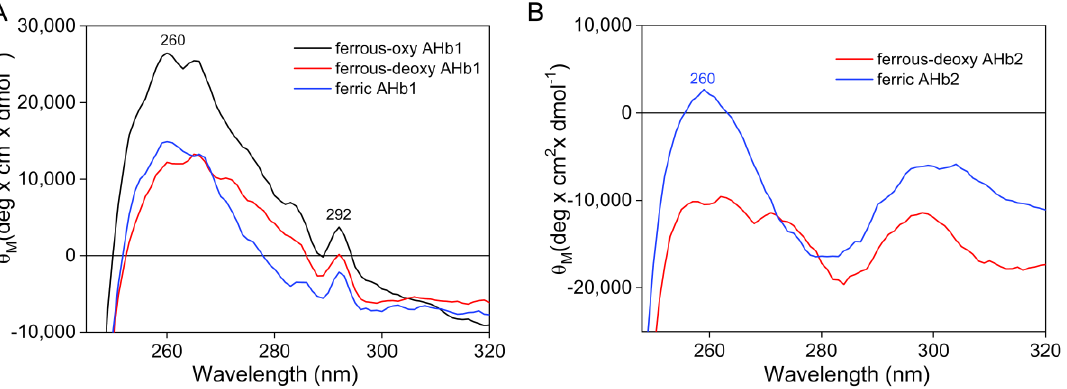
Figure 7. CD spectra of AHb1 ( A ) and AHb2 ( B ) in the near-UV region. Protein concentrations were 30 µM heme, in 10 mM Tris-HCl buffer, pH